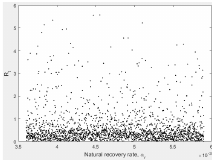
Figure 8. The scatter plot is having poor pattern indicating that the correlation between R t and α r is week implying that R t is poorly sensitive to α r .